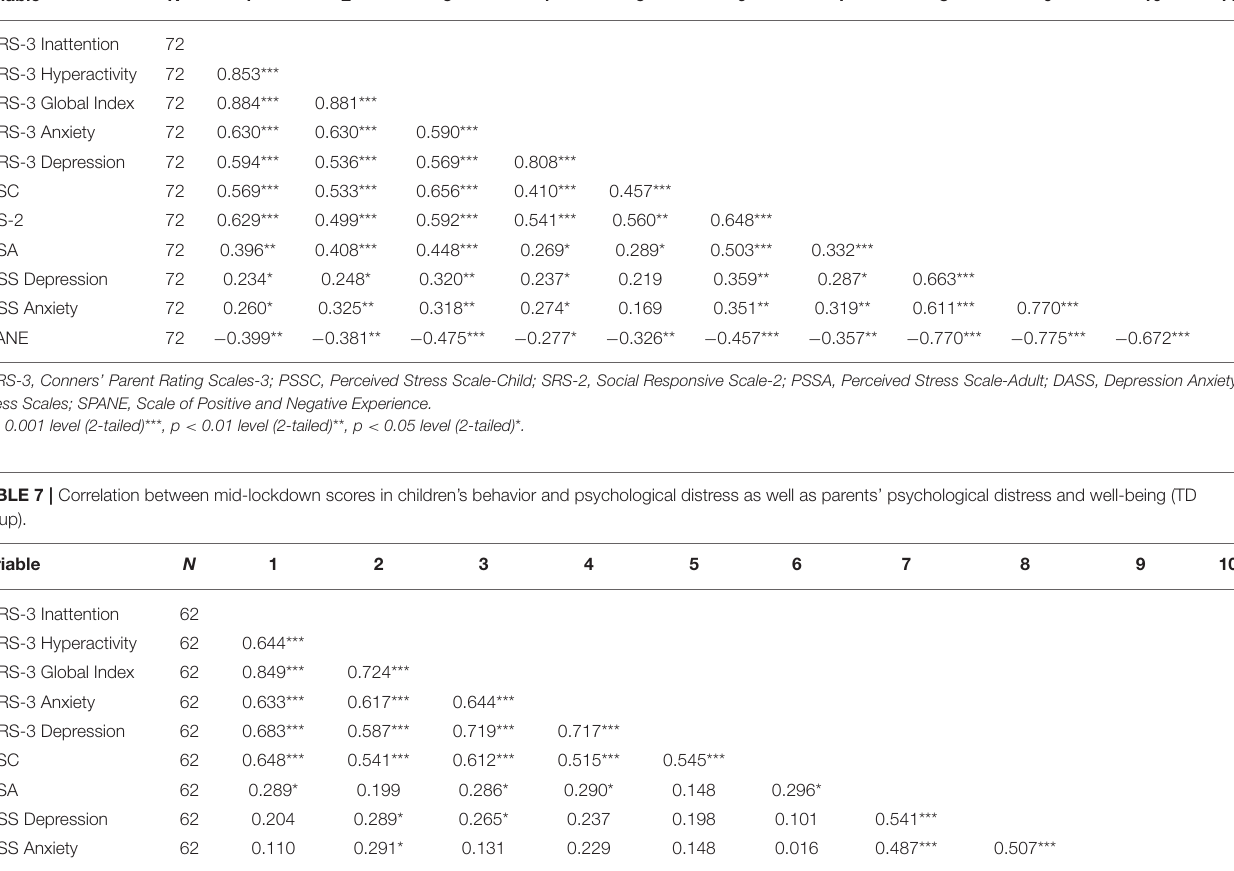
TABLE 6 | Correlation between mid-lockdown scores in children’s behavior and psychological distress as well as parents’ psychological distress and well-being (ASC group). Variable